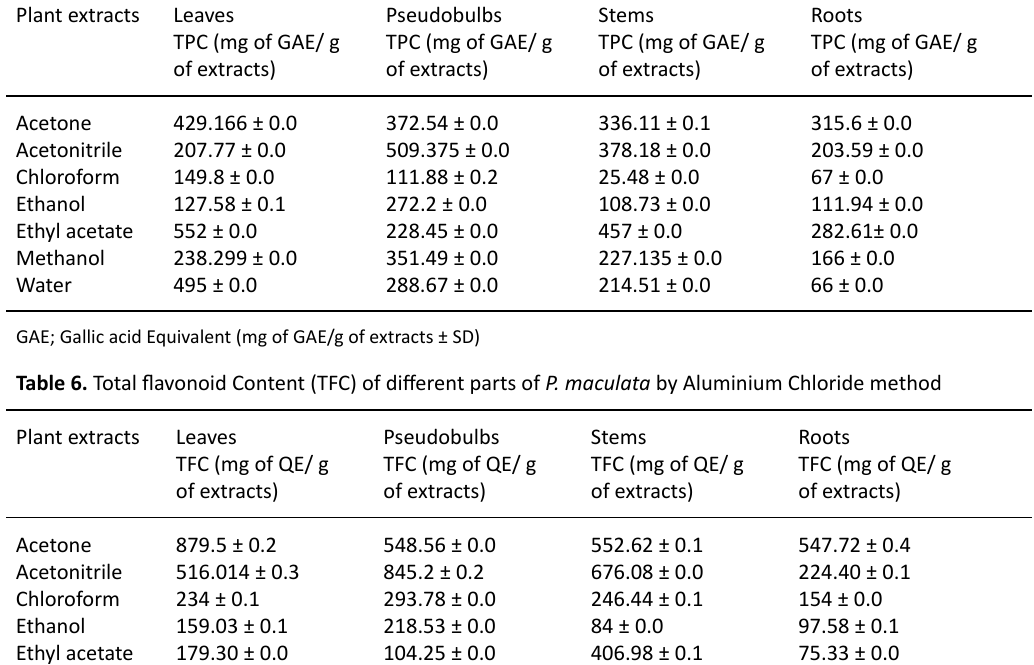
table 5. Total Phenolic content (TPC) of different parts of P. maculata by Folin Ciocalteau reagent Plant extracts